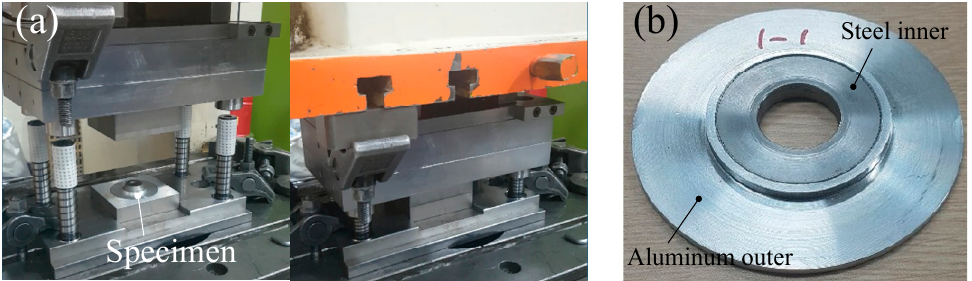
Figure 11. Die set and fabricated specimen: ( a ) die set; ( b ) specimen.